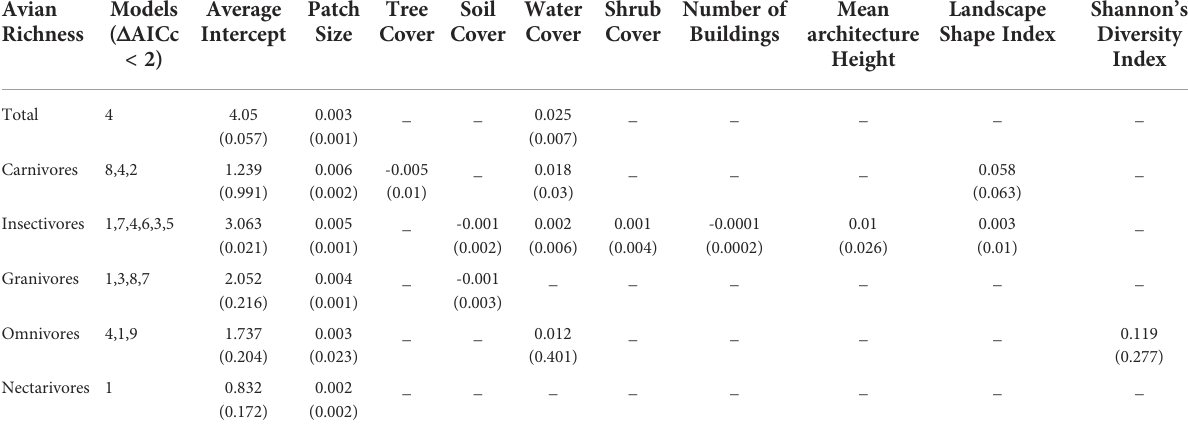
TABLE 5 Results of model selection process to quantify the in fl uence of urban green space (site-level) and urban built form (matrix-level) attributes on avian richness in urban green spaces. Avian Models Average Patch Tree Soil Water Shrub Number of Richness ( D AICc Intercept Size Cover Cover Cover Cover Buildings < 2)